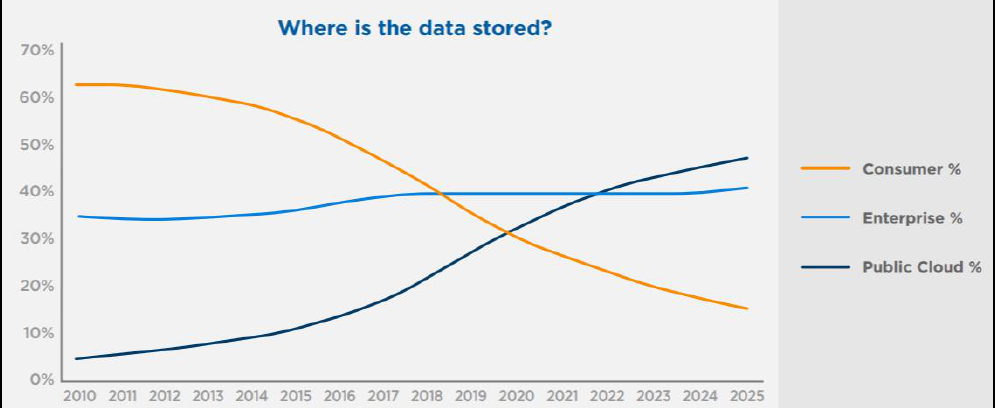
Figure 4. Where is the data stored? [26].